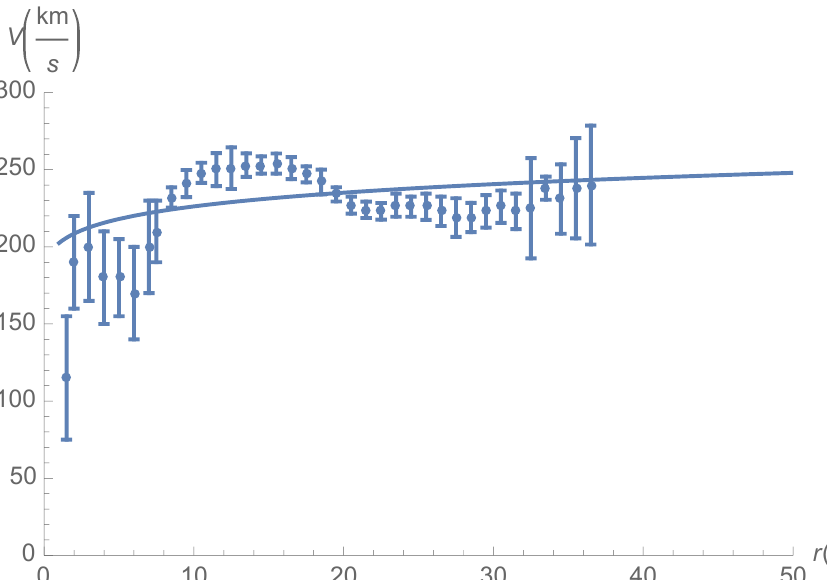
Figure 4. The rotational velocity curve for the galaxy M31. Dots are observed data [45], and the solid curve is the result of Equation (9) for the following parameters: Ω = 100 r − 0.99 + 100/ r , a = 1000 r − 0.9 according to [42], b = 0.01 and c = 0.005.